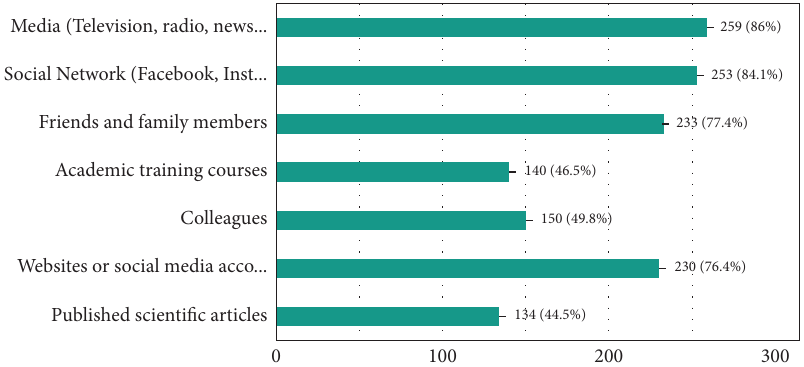
Figure 1: What are your sources of information about the COVID-19? (Select all that apply) 301